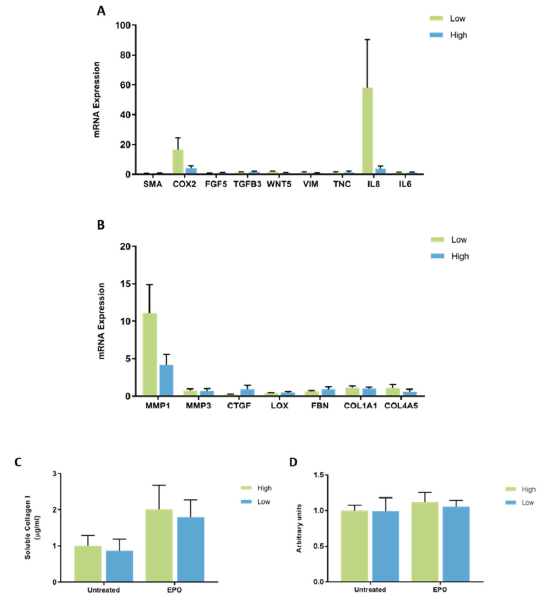
Figure 7. The effect of EPO on mRNA expression and collagen production in mammary fibroblasts isolated from women with high and low mammographic density. Messenger RNA expression of cancer-associated genes ( A ) and genes involved in extracellular matrix regulation and collagen production ( B ) measured by RT-PCR in human mammary fibroblasts from women with high ( n = 7) and low ( n = 9) mammographic density following treatment with 2.5 µ g/mL of EPO for 72 h. mRNA expression normalised to HPRT1 expression and presented as relative expression where the average for untreated control is 1. Collagen production was measured using collagen 1 ELISA ( C ) and insoluble collagen measured by sirius red staining ( D ). Data presented as mean + SEM with statistical analysis performed using a linear mixed-effects model Tukey’s post hoc